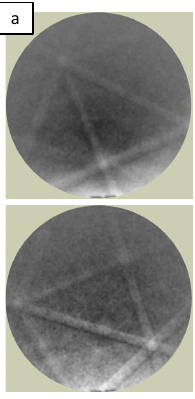
Figure 2. Graphical representation of the procedure used for indexing EBSD data, showing the raw signal intensity map with diffraction bands ( a ), the dual space resulting from the Hough transform with colored markers ( b ), indicating the characteristic diffraction lines of the spot under investigation ( c ), which were used to assign the data to the characteristic Kikuchi pattern of γ - (top) or α -Al 2 O 3 (button) ( d